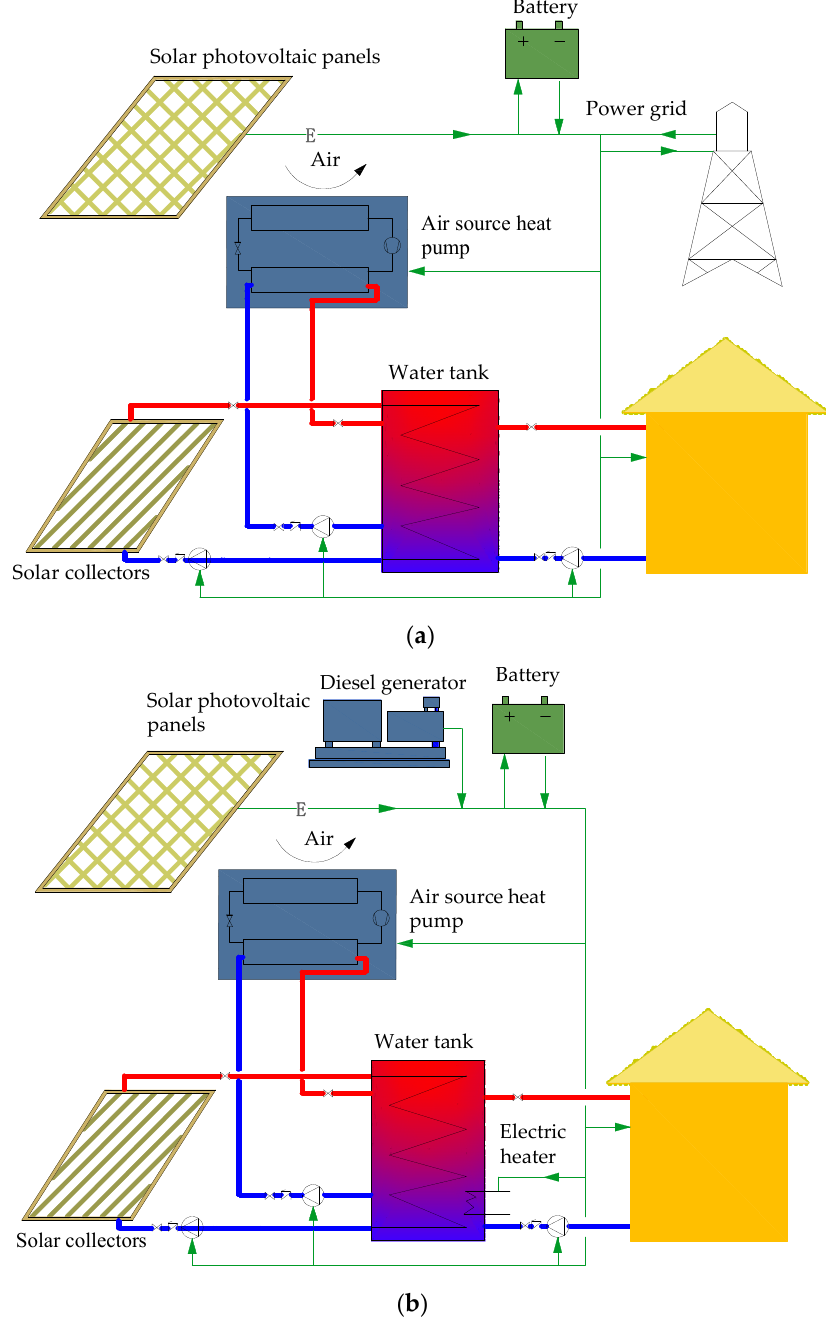
Figure 1. Two types of distributed solar energy systems. ( a ) Grid-connected system; ( b ) off-grid system.